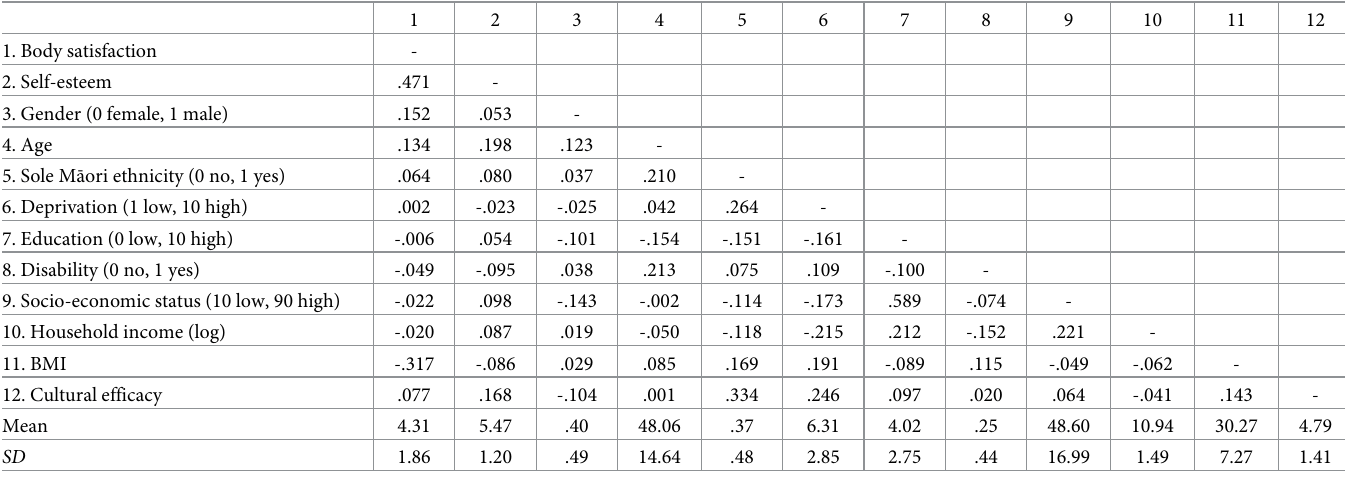
Table 1. Bivariate correlations and descriptive statistics for all